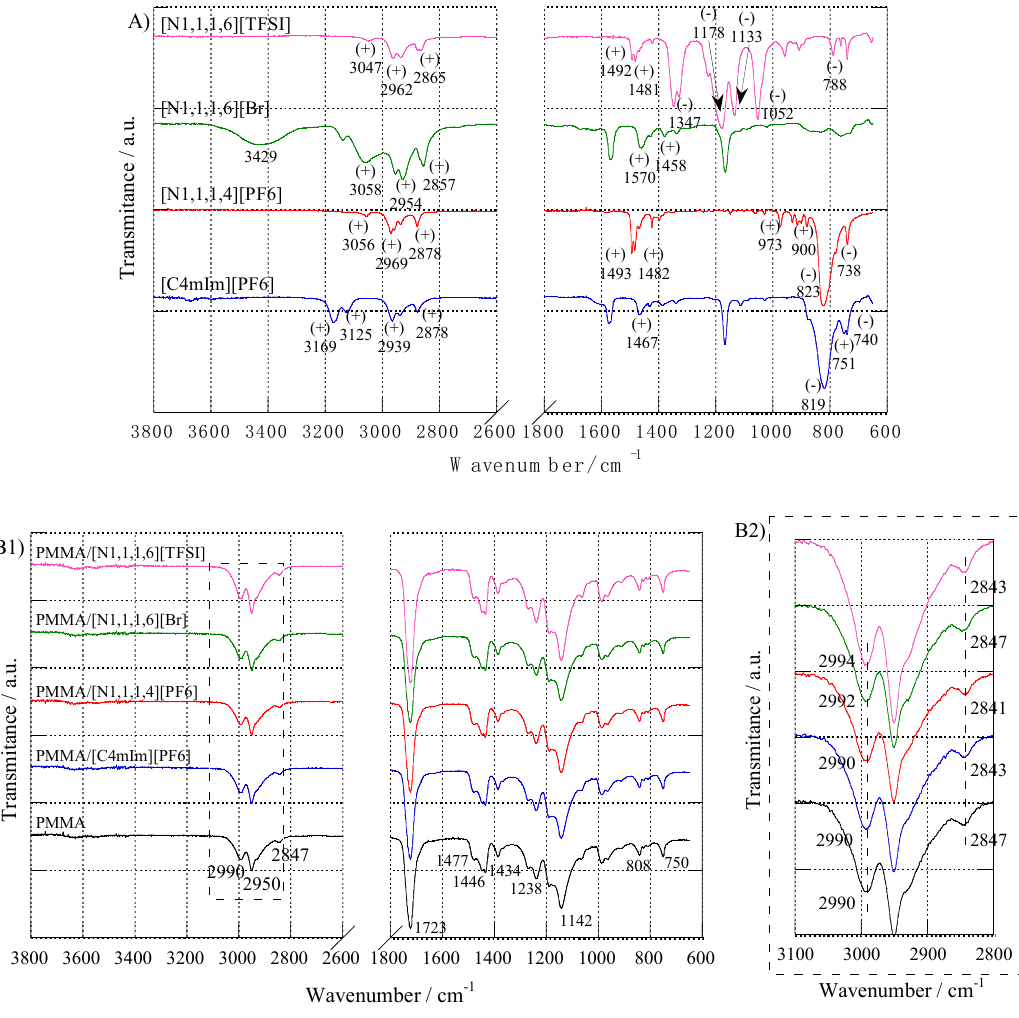
Figure 3. FTIR spectra of: ( A ) neat imidazolium and ammonium-based ILs, ( + ) and ( − ) captions highlight the main absorption bands for the cation and anion, respectively; ( B1 ) neat PMMA and IL-modified PMMA materials; and ( B2 ) displays the same spectra ranging only from 3100 to 2800 cm − 1 ).